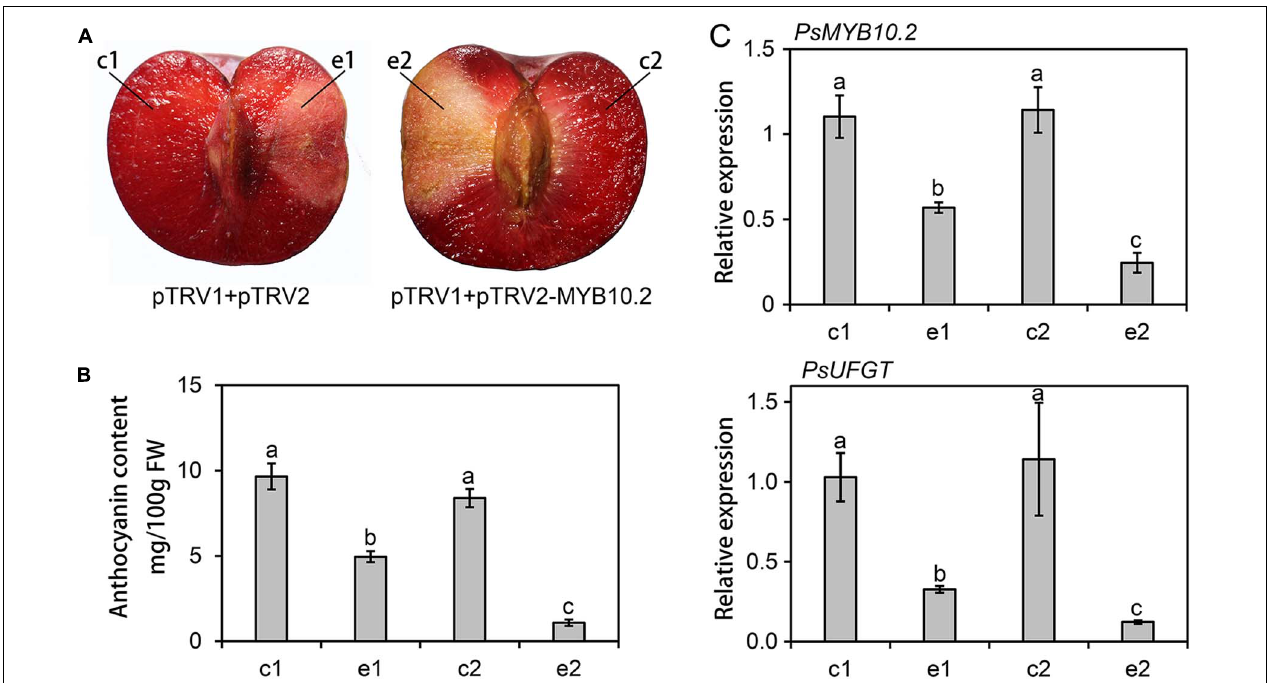
FIGURE 8 | Functional analysis of the PsMYB10.2 gene by TRV-based virus-induced gene silencing. (A) Silencing of the PsMYB10.2 gene in ‘Fuhongli’ plum fruit at ripening stages. (B) Anthocyanin content in the flesh tissues around the infiltration sites (e1 and e2) and the opposite non-infiltrated sites (c1 and c2). FW, fresh weight. (C) Expression levels of the PsMYB10.2 and PsUFGT in the flesh tissues. The flesh tissues were collected 7 days after infiltration. Error bars represent the standard errors for three replicates. Different lowercase letters indicate significant differences among treatments according to one-way ANOVA test ( P < 0.05).